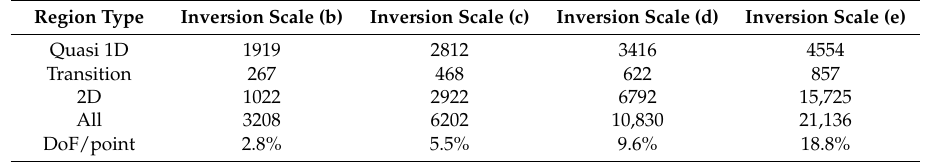
Table 4. Number of degrees of freedom (DoF) per point for the successive multiscale